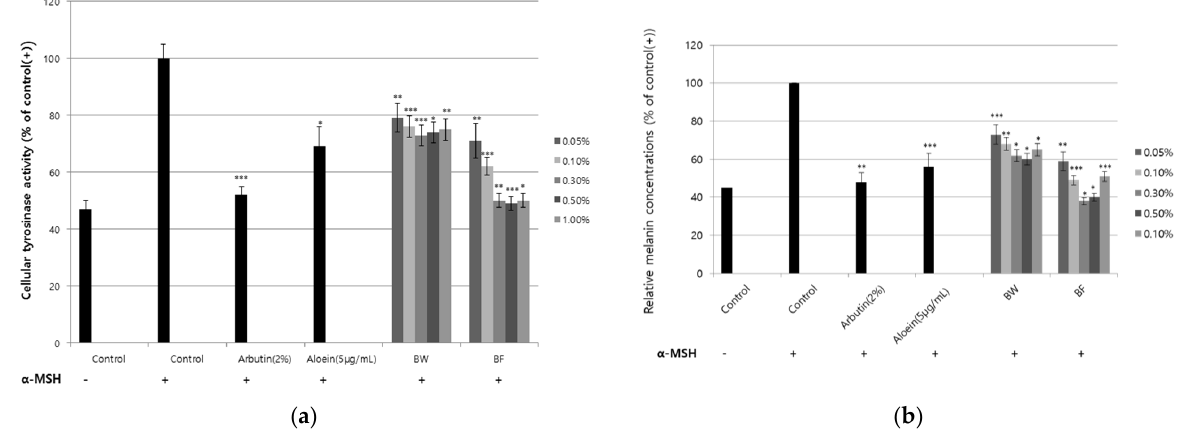
Figure 6. Inhibition of cellular tyrosinase activities ( a ) and melanin synthesis ( b ) in melanoma cells by treating various concentrations of two extracts of aloe skin leaf, and 5 μ g/mL aloesin and 2% arbutin. BW: Water extract of aloe skin leaf at 100 °C for 24 h. BF: Fermented extract of aloe skin leaf fermented with L. plantarum BN41 at 37 °C for 3 days and further extracted by an ultrasound generator at 20 kHz for 4 h. The mean values ± SD for separate triplicate experiments are shown, and error bars indicate the SD. The significance of the difference was set to * p < 0.05, ** p < 0.01 and *** p < 0.001 compared with the control (+).